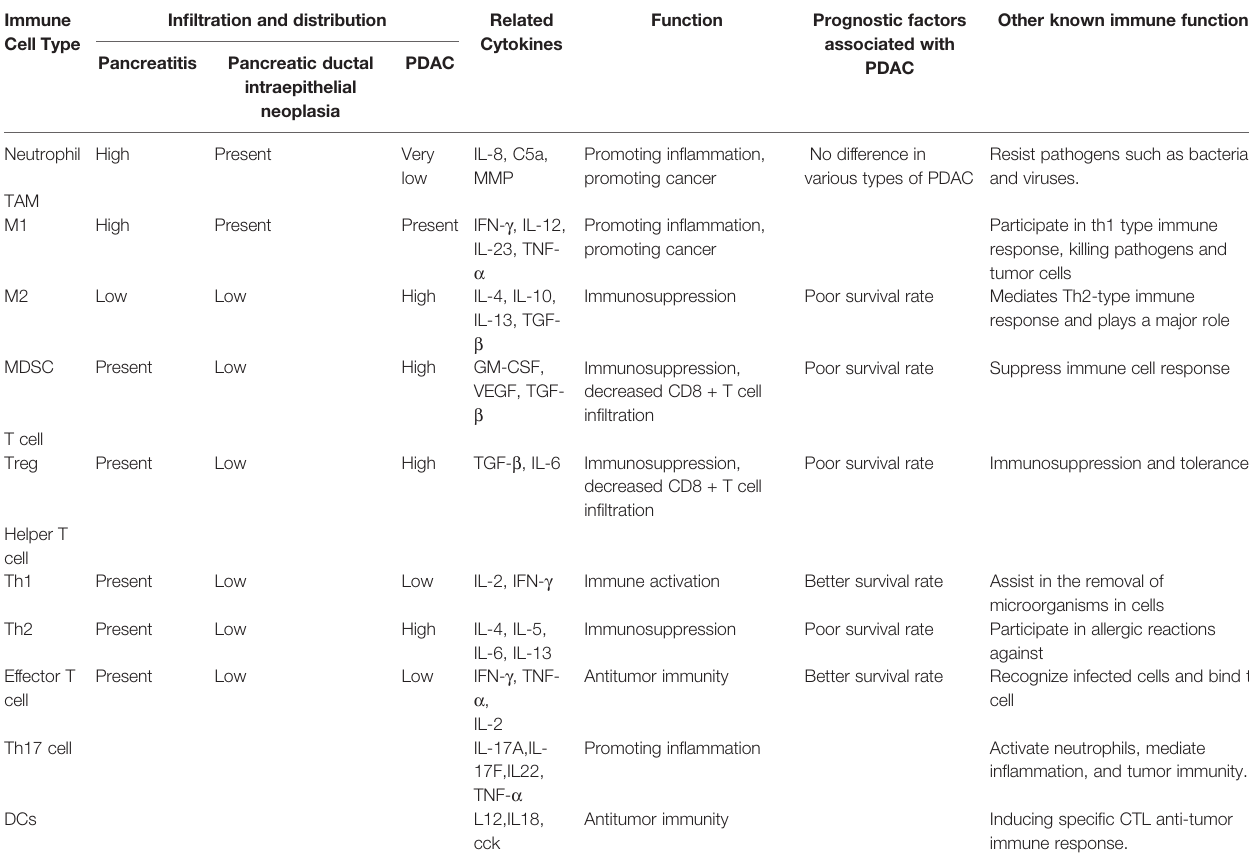
TABLE 2 | Summary of immune cells in the tumor microenvironment of pancreatic adenocarcinoma. Immune Cell